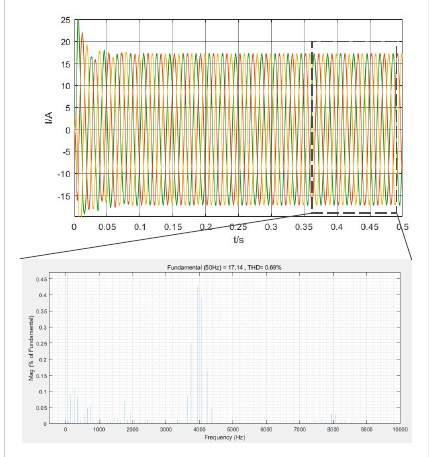
Figure 18. The amount of THD in line voltage coordinate when m = 0.75, D = 0.1.